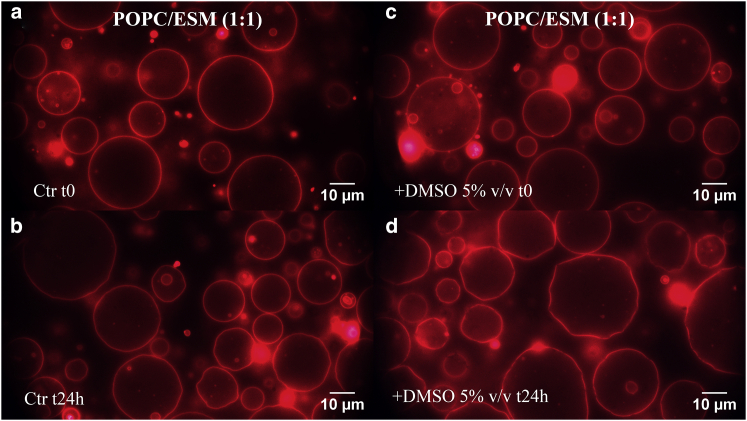
Representative fluorescence microscopy images of POPC/ESM 1:1 GUVs acquired (a) immediately after preparation (t = 0) and (b) after 24 h in water as a control. Images acquired of the binary system with added DMSO (5% v/v) at (c) t = 0 and (d) after 24-h incubation. Membrane undulations are clearly visible in the latter panel. More than 100 vesicles were investigated for each sample. To see this figure in color, go online.